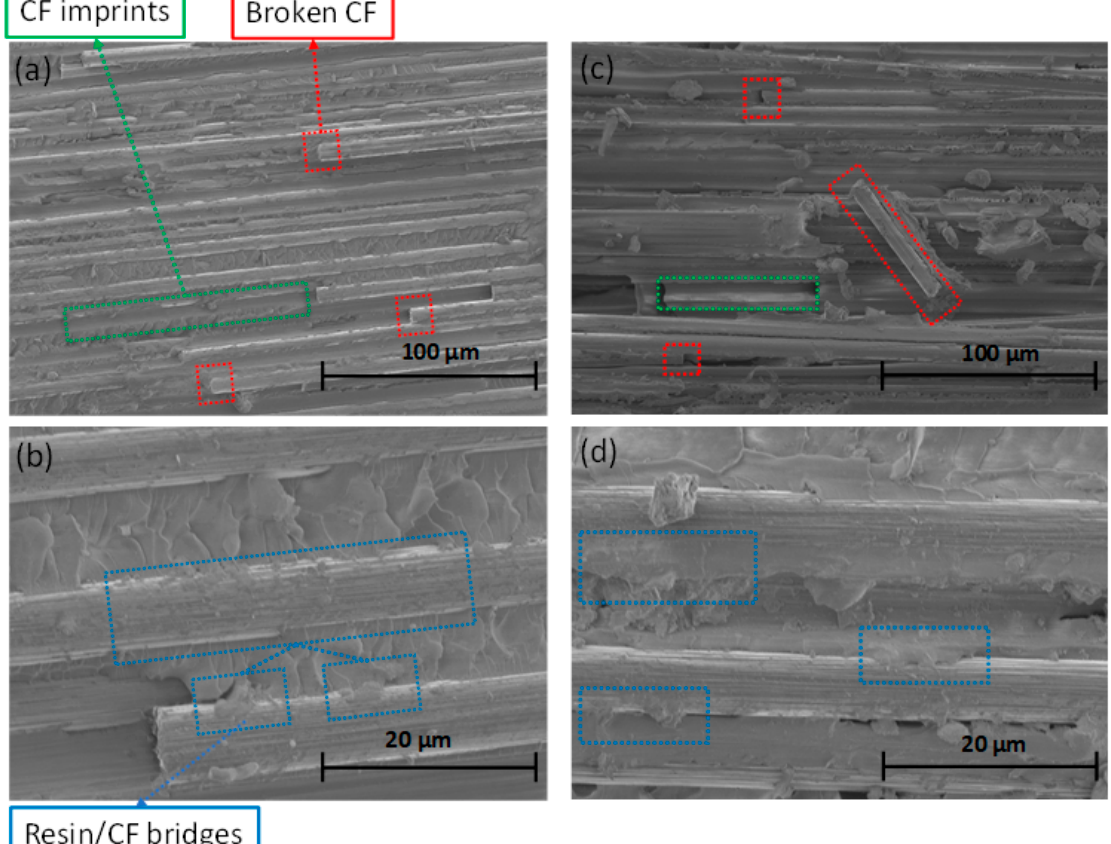
Figure 13. Fractography analysis of the reference ( a , b ) and PCF 4.25 W ( c , d ) samples after Mode I test.